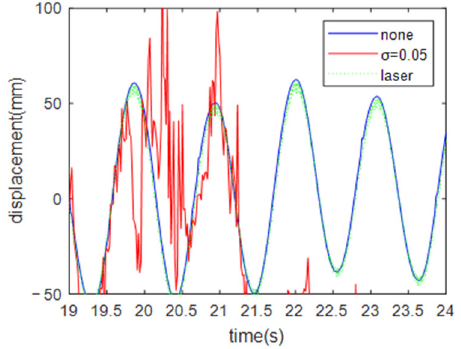
Figure 7. Displacement identification results under white noise of σ = 0.05.